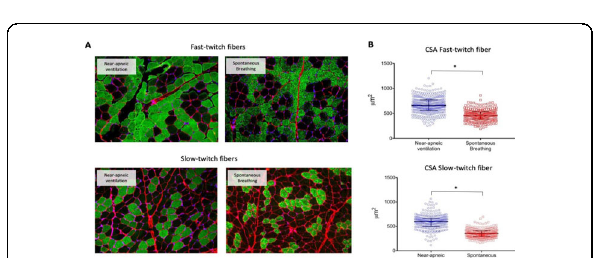
Fig. 2 (abstract 001085). ( A ) Immunohistochemically stained cross- sections of diaphragm muscle fiber biopsies in experimental groups by fiber type. Original magnificatio: 20x. Red: wheat germ agglutinin indication membranes. Green: Myosin heavy chain antibody specific for fast - and slow-twitch fibers.( B ) Diaphragm fiber cross-sectional area (μm 2 ) in slow- and fast-twitch fibers by group, CSA: cross- sectional are. *p <